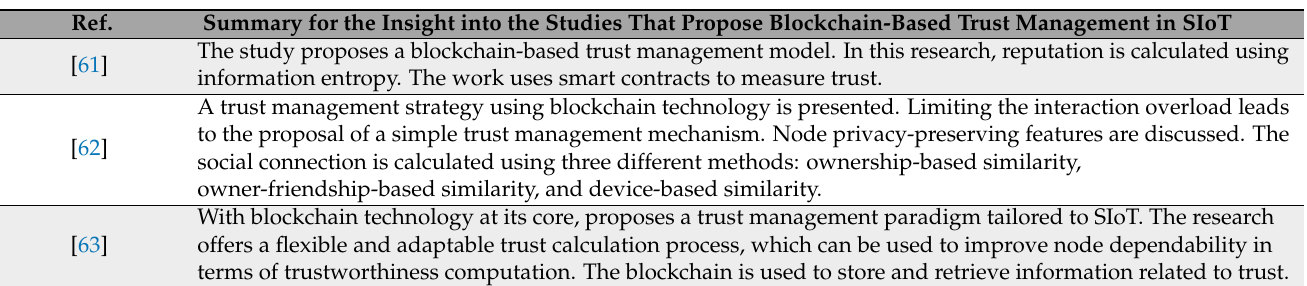
Table 2. Blockchain-based Trust Management in